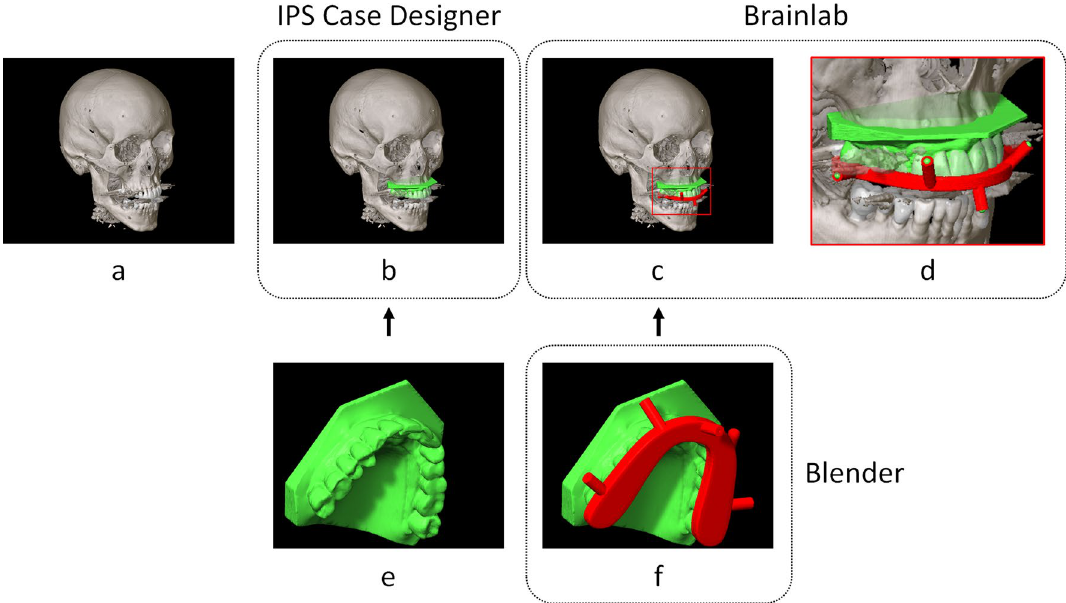
Figure 2. Virtual splint registration workflow. The computed tomography scan ( a ) and the intra-oral scan ( e ) are fused in IPS case designer software ( b ). In blender, a navigation splint is designed with five cylinders with an indentation augmented on it ( f ). The dental model and splint are imported in the Brainlab environment ( c ): the dental model for control purposes and the navigation splint to indicate the registration points ( d